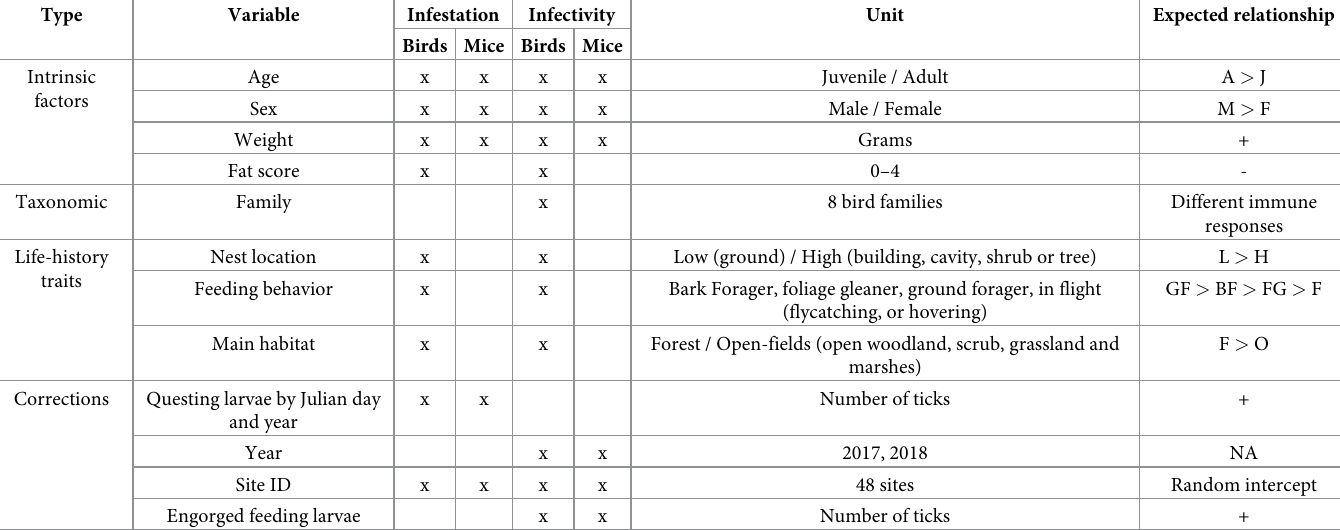
Table 1. Description of variables tested in host infestation and infectivity